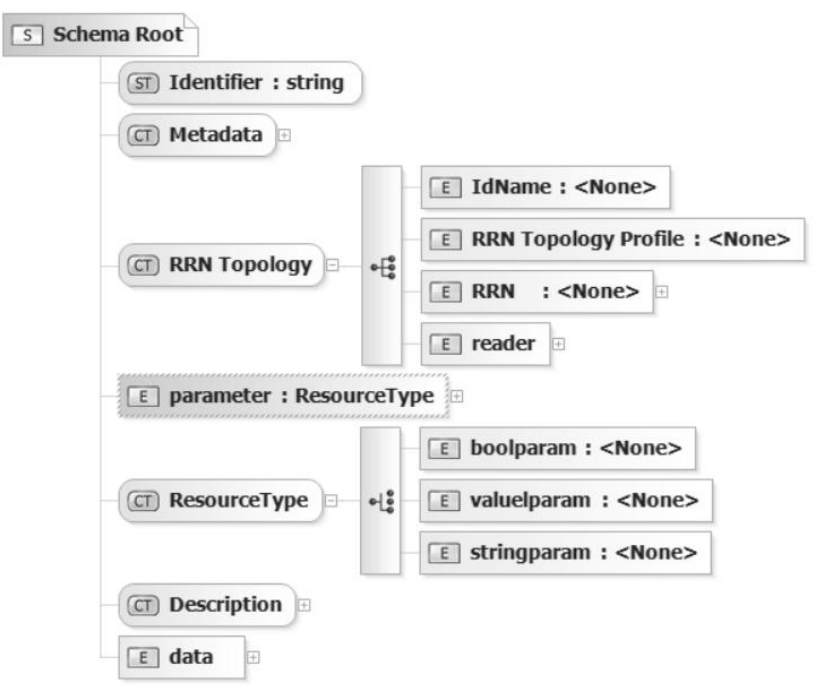
Figure 2. RRTL main